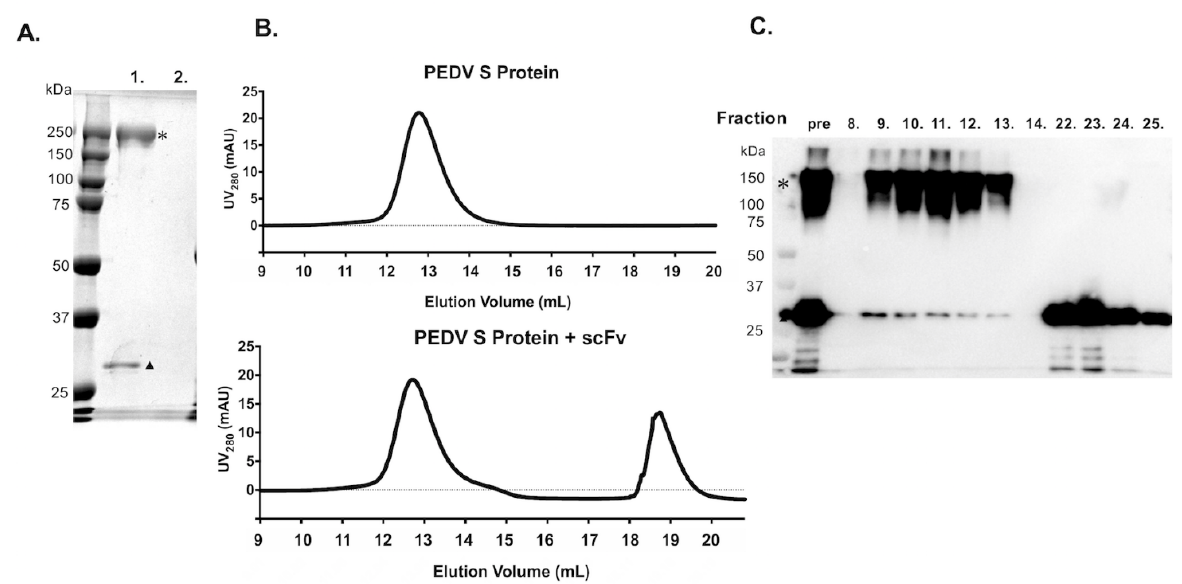
Figure 5. Evaluation of binding between scFv and PEDV S protein by MWCO filtration and SEC. ( A ) The SDS-PAGE of 100 kDa MWCO filtrated scFv with (lane 1) and without (lane 2) the PEDV S protein. ( B ) Size-exclusion chromatograms of the PEDV S protein without (top) and with (bottom) the scFv. ( C ). Western blot analysis of the elution fractions corresponding to the two elution peaks of the scFv mixed with the PEDV S protein (bottom chromatogram of ( B )), sorted by SEC. The expected bands of PEDV S protein were labeled with asterisks. The retained scFv after the 100 kDa MWCO filtration was labeled with sloid triangle.